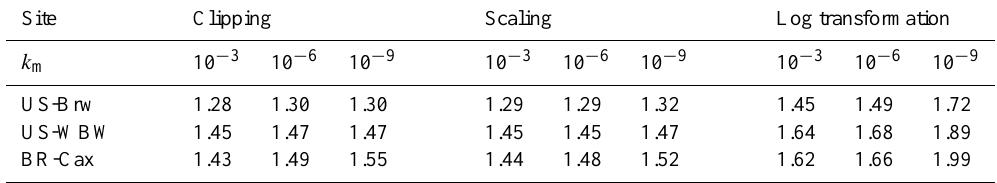
Table 1. Wall time for CLM–PFLOTRAN relative to CLM for spin-up simulation on OIC (ORNL Institutional Cluster Phase5). Site Clipping Scaling Log transformation k m 10 − 3 10 − 6 US-Brw